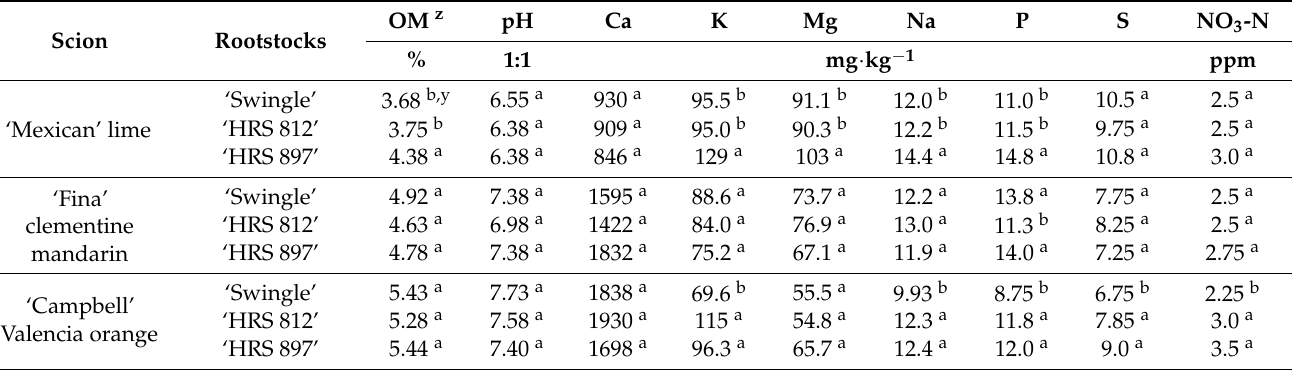
Table 1. Soil nutrients in 2021 of three citrus cultivars grafted in three different rootstocks and growing under fertigation practices on Coto series soil at the Agricultural Experiment Station of Isabela, Puerto